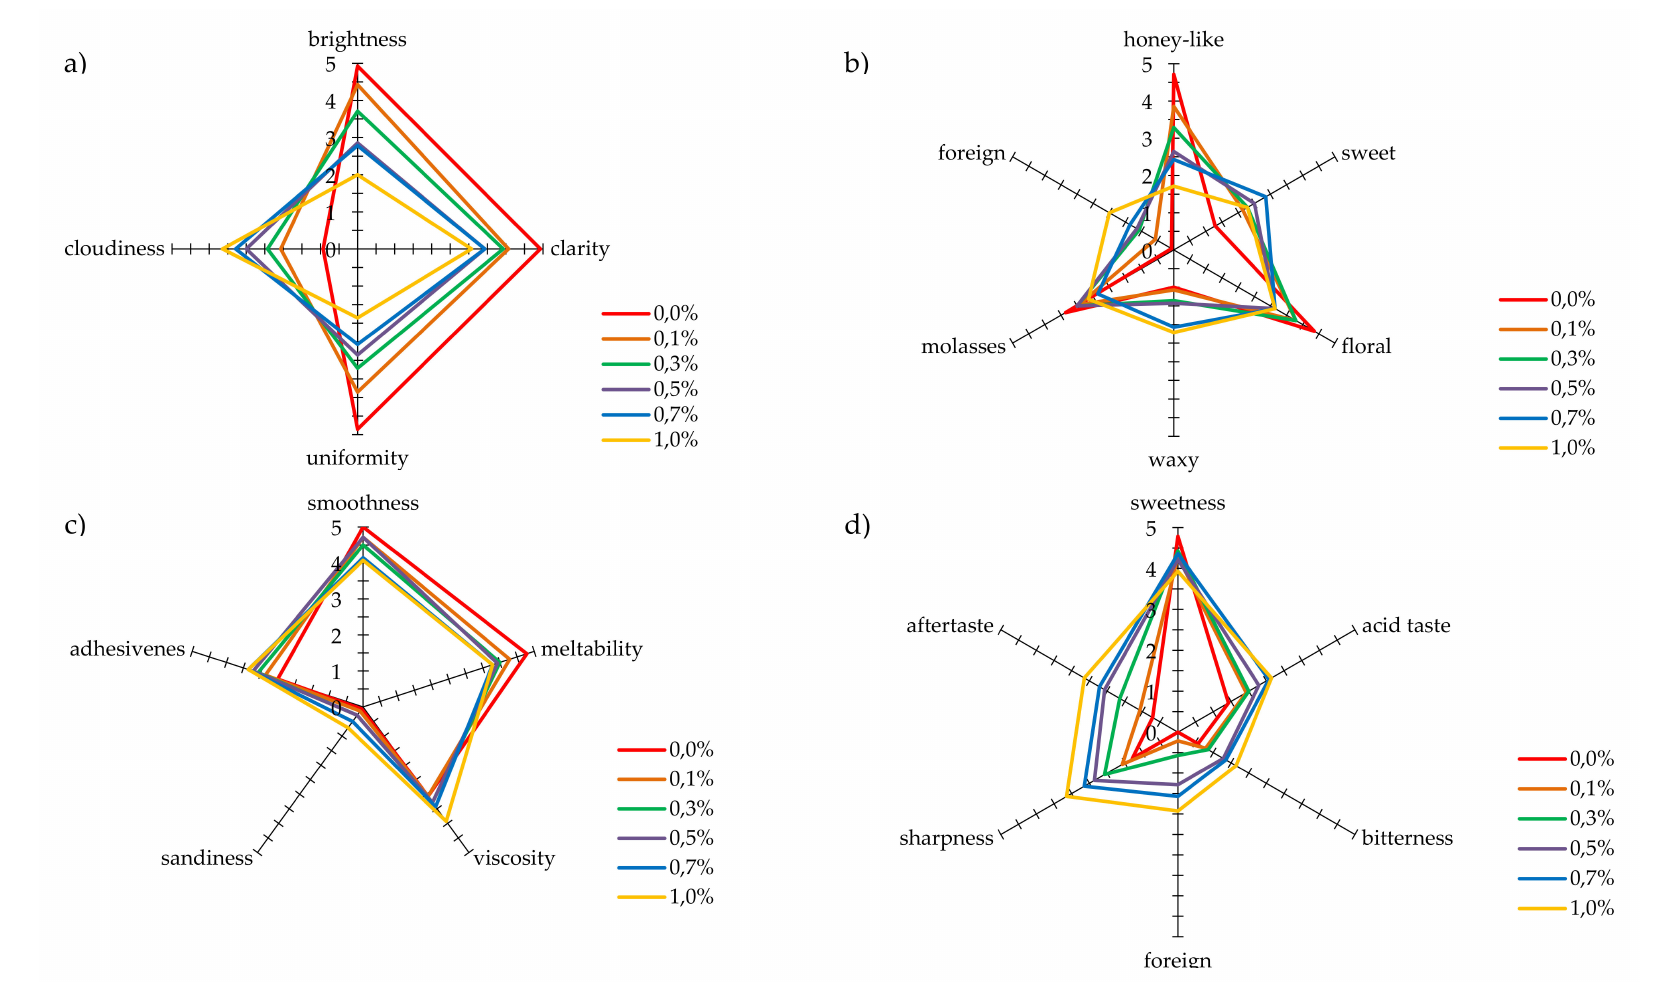
Figure 2. The results of sensory profiling analysis for: ( a ) color, ( b ) smell, ( c ) texture, and ( d )